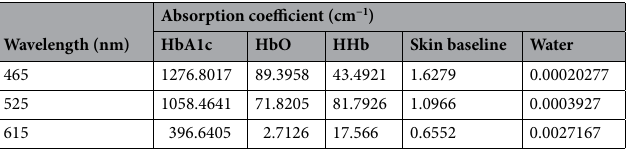
Table 2. Absorption coefficients of HbA1c, HbO, HHb, skin baseline, and water for the respective light wavelengths.